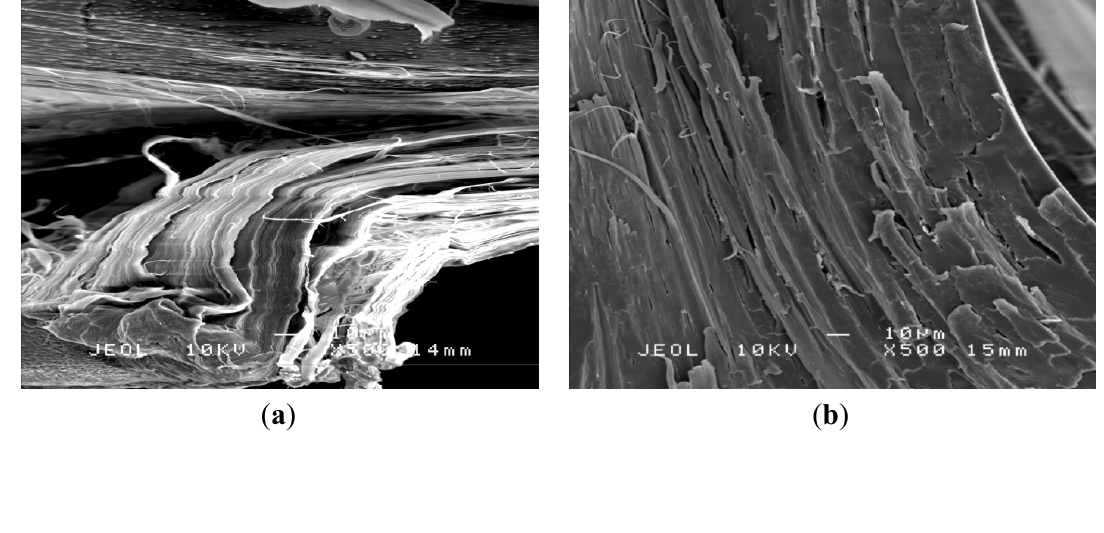
Figure 8. SEM images of ( a ) PLA/PEG; and ( b ) PLA/PEG/0.3 wt% xGNP